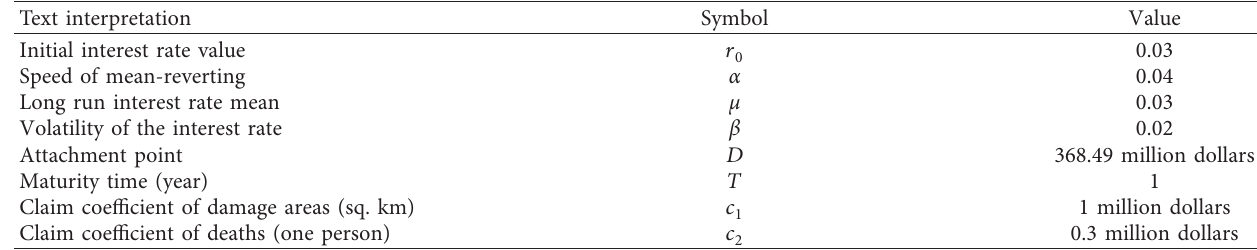
Table 3: Basic parameter values.